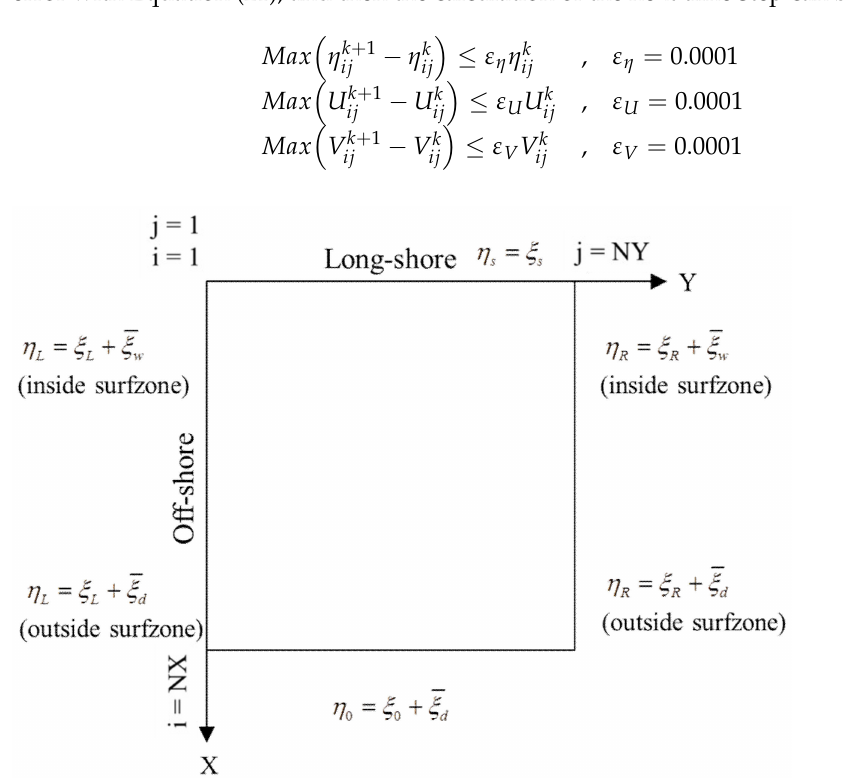
Figure 1. Hydrodynamic model boundary condition